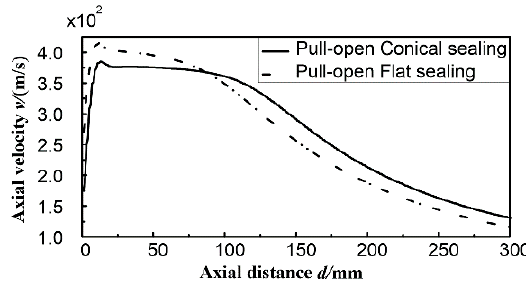
Figure 15. The velocity distribution on the outflow centerline of pull-open injector.